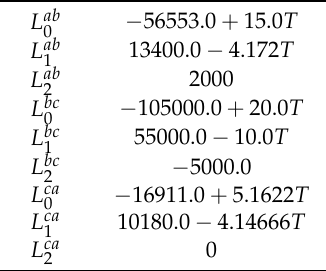
Table A1. Binary interaction parameter used for liquid